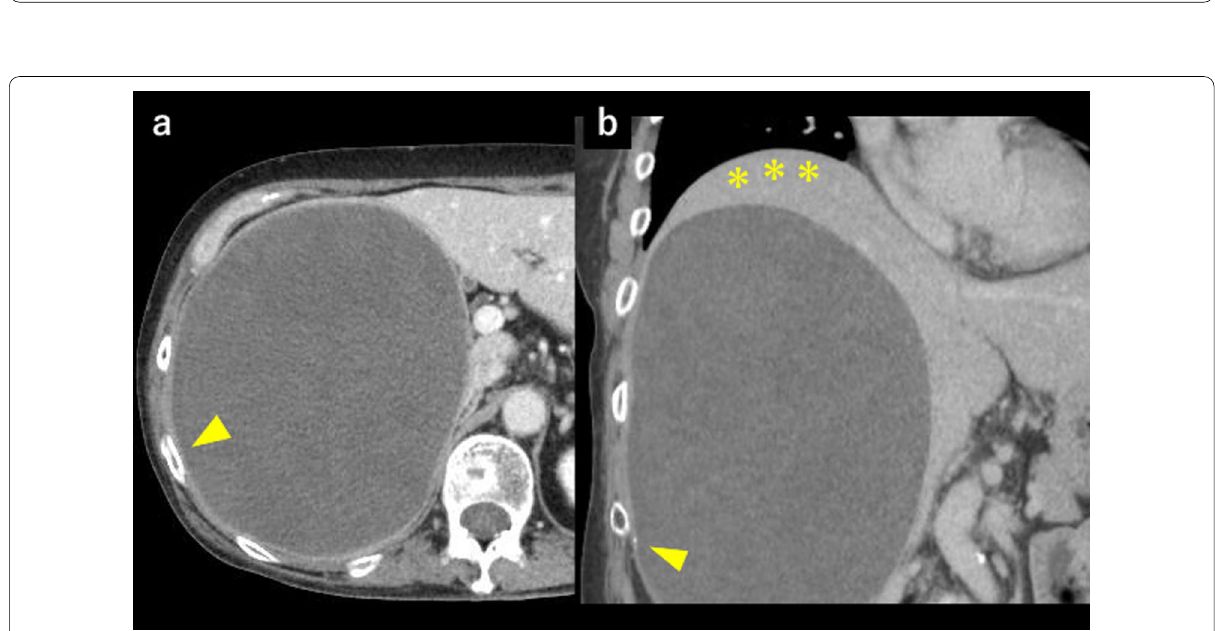
Fig. 1 Abdominal ultrasonography. The inside of the tumor was recognized as a structure divided into many spaces, and blood flow was confirmed in the septum